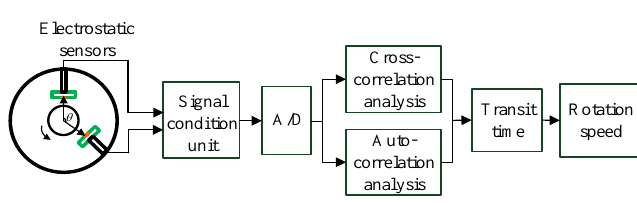
Figure 2. Principle of the rotational speed measurement using electrostatic sensors.